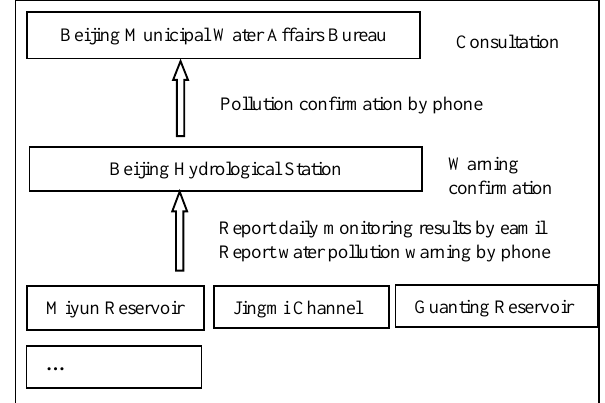
Figure 1. Conventional water quality transmission mode